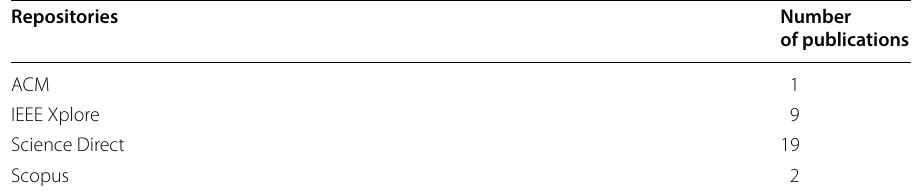
Table 4 Results of the identification of relevant work